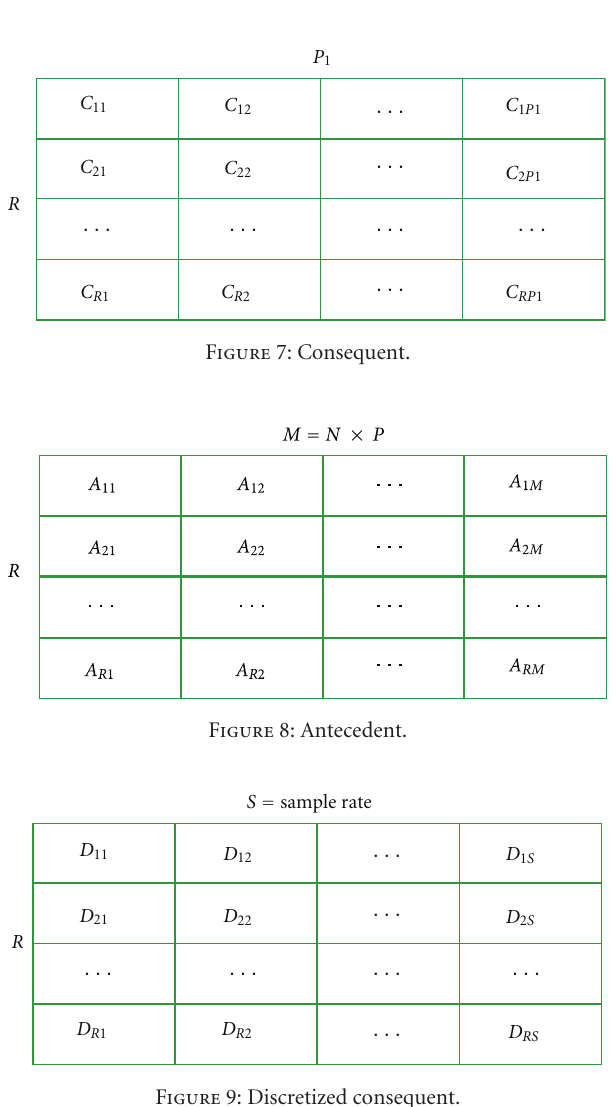
Figure 9: Discretized